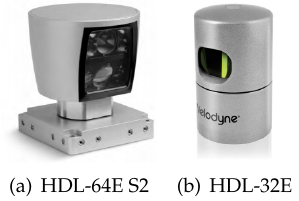
Figure 3. The 3D light detection and ranging (LiDAR) used in this